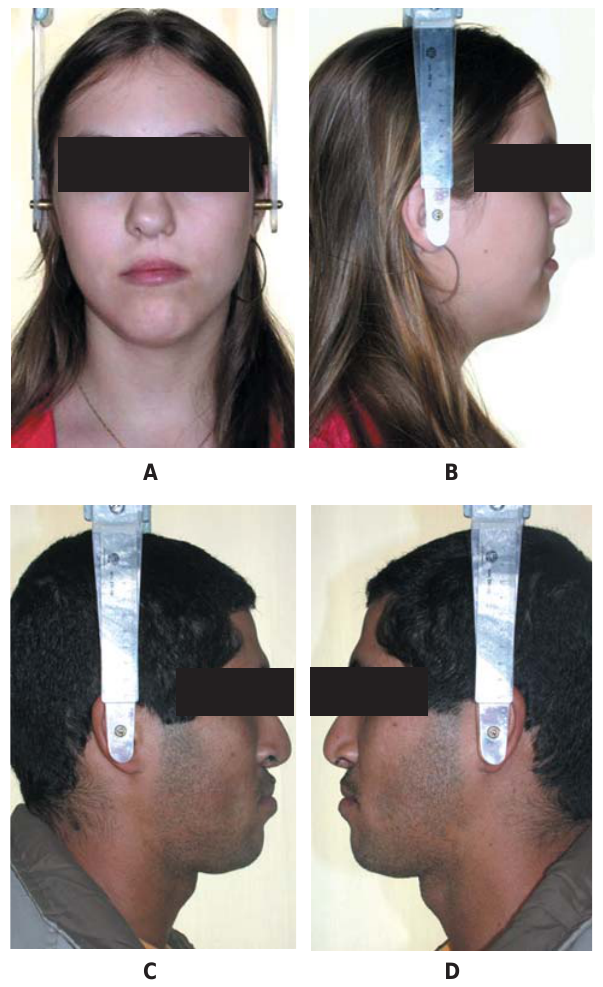
FIGURE 3- Patients with cleft lip and palate. Facial analysis in unilateral (A and B) and bilateral (C and D) cleft lip and palate in adult patients, operated at conventional ages and rehabilitated at HRAC/USP. Nasomaxillary deficiency